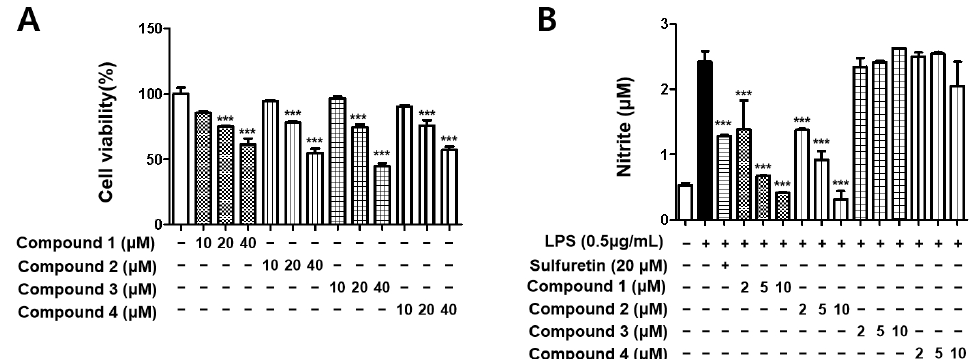
Figure 2. The effects of compounds on cell viability ( A ) and nitrite content ( B ). BV2 cells were incubated for 24 h with various concentrations of compounds 1 – 4 . Cell viability was determined using the 3-(4,5-dimethylthiazol-2-yl)-2,5-diphenyltetrazolium bromide assay. BV2 cells were pretreated for 3 h with indicated concentrations of compounds and stimulated for 24 h with lipopolysaccharide (LPS) (0.5 µ g/mL). Bars represent means ± standard deviation of three independent experiments. *** p < 0.001 compared with LPS-treated group.